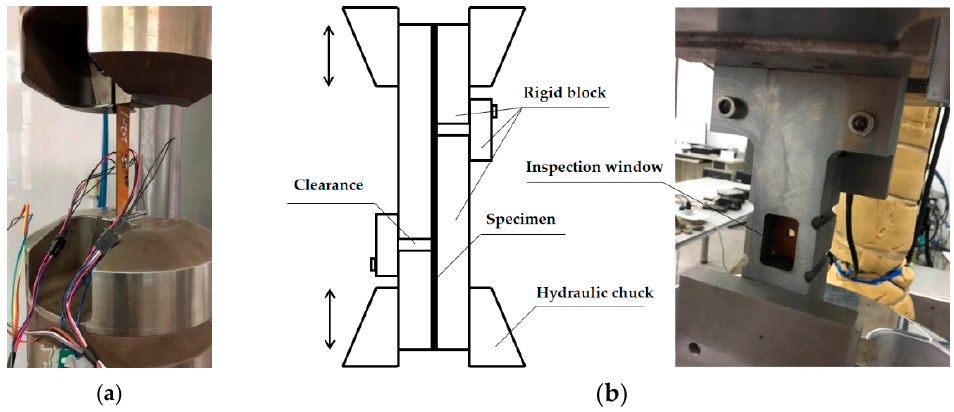
Figure 6. Mechanical tests apparatus: ( a ) static tensile tests; ( b ) cycling